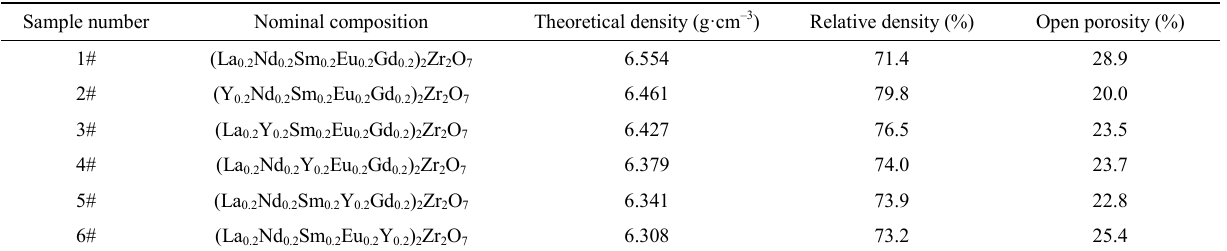
Table 1 Theoretical density, relative density, and open porosity of the ceramics after sintering at 1500 ℃ for 3 h Sample